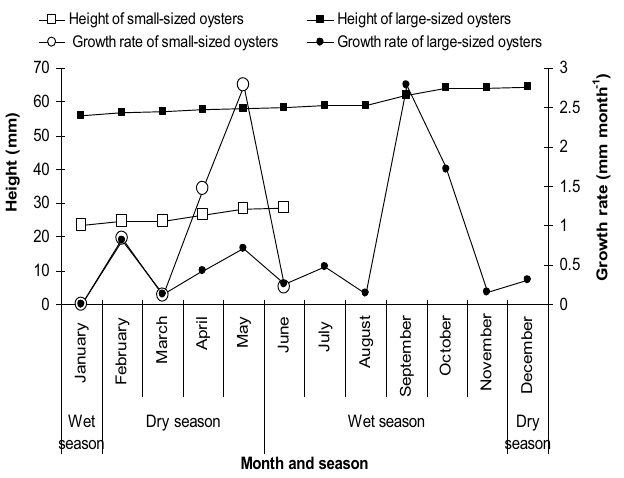
Fig. 4. Mean height increment and growth rates of small-sized and large-sized individuals of E. elliptica held in cages from January to June 2009 in the Pendjari River (Benin).